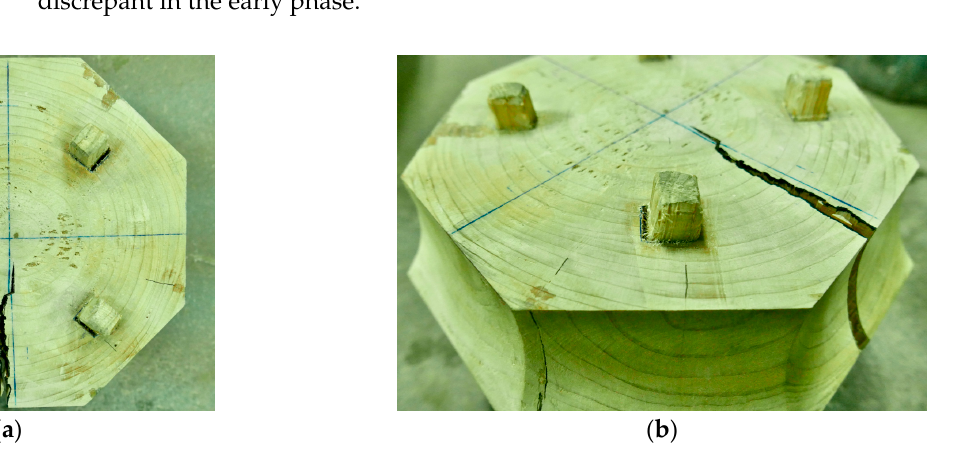
Figure 16. Failure modes of Zuo-Dou after shear test: ( a ) hole of the STS, specimen No. 2; ( b ) hole caused by STS, specimen No. 2; ( c ) STS in Zuo-Dou connection, specimen No. 4; ( d ) STS in Zuo-Dou joint, specimen No. 5.